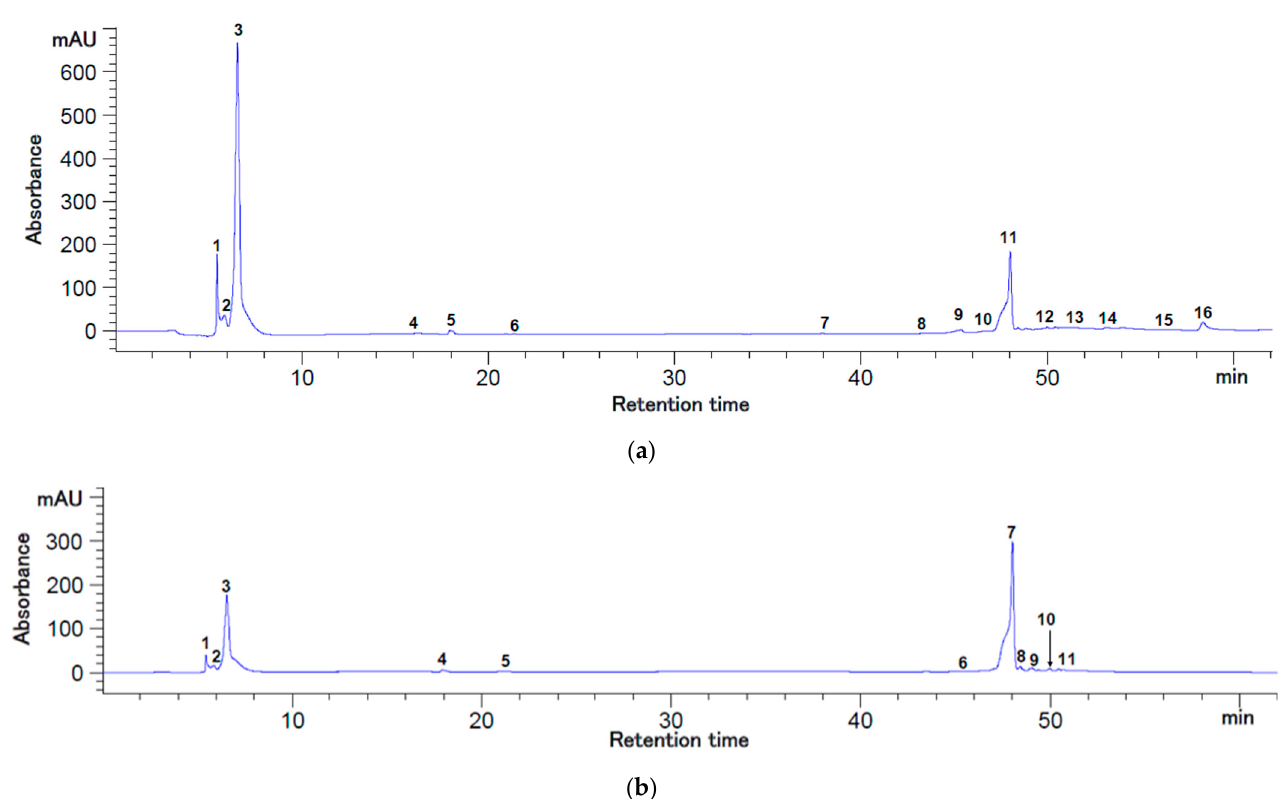
Figure 2. HPLC chromatograms for the flavonoids and polyphenols from rosehip’s extract (2 M) at 280 nm ( a ) and 320 nm ( b ). Peaks’ identification: ( a ) 1—gallic acid; 2—chlorogenic acid; 3—epicatechin; 10—quercetin 3- β -D-glucoside; 11—quercetin; 13—kaempferol, 4–9, 12, 14–16—unidentified peaks; ( b ) 1—gallic acid; 2—chlorogenic acid; 3—epicatechin; 7—quercetin; 11—kaempferol; 4–6, 8–10—unidentified peaks.